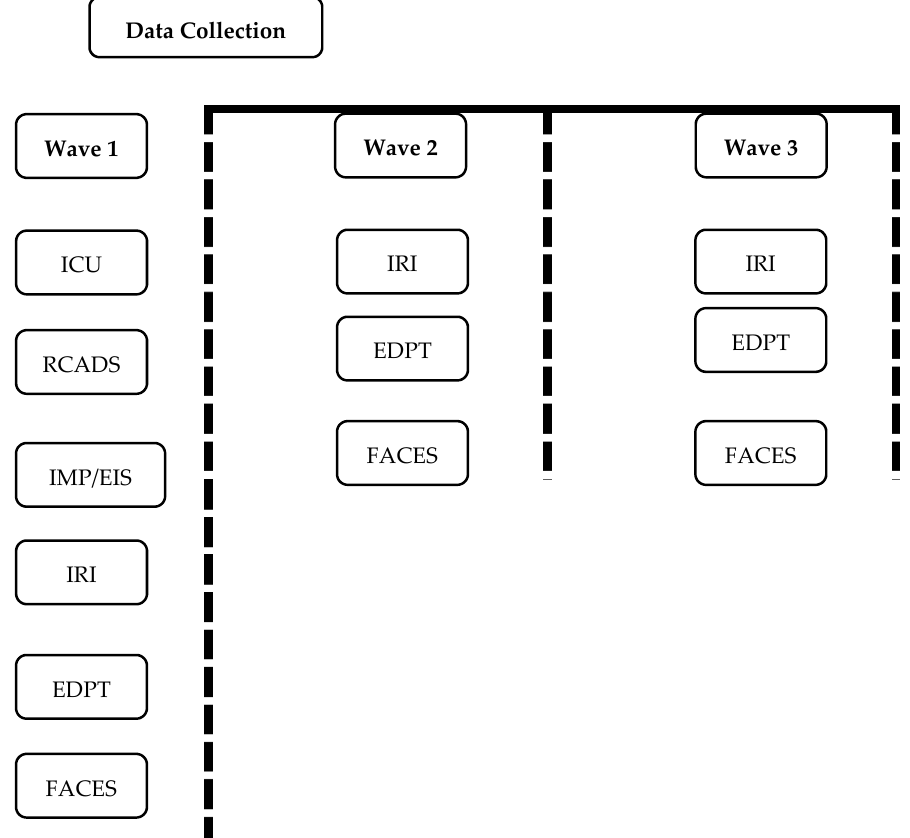
Figure 4. Summary of Waves of Data Collection. Note: ICU = Inventory of Callous ‐ Unemotional Traits; RCADS = Revised Child Anxiety and Depression Scale; IMP = Impulsivity/Conduct Problems Scale of the APSD; EIS = Eysenck Impulsiveness Scale; IRI = Interpersonal Reactivity Index; EDPT = Emotional Pictures Dot ‐ Probe Task; FACES = The University of New South Wales Facial Emotion Task.